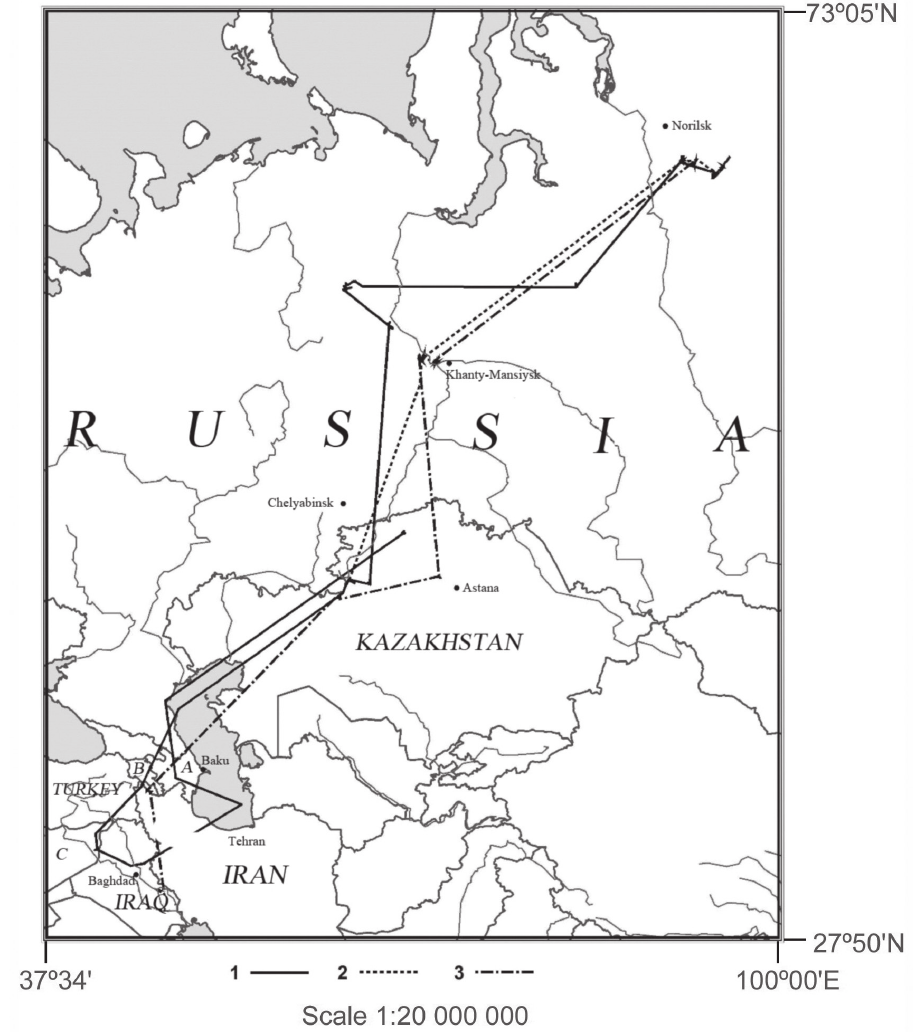
Figure 3. Flight scheme of Anser erythropus based on the results of telemetry tracking. Note: 1, 2, 3 flight trajectories of three lesser white-fronted geese; A Azerbaijan; B Armenia; C